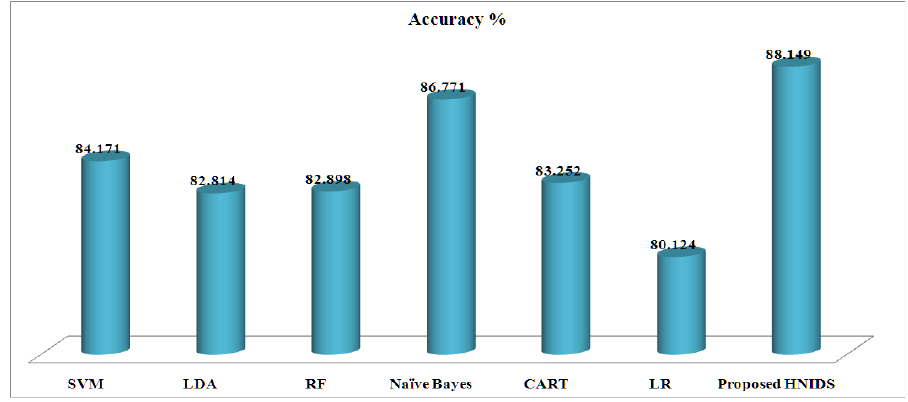
Figure 6. Accuracy % for proposed HNIDS model for